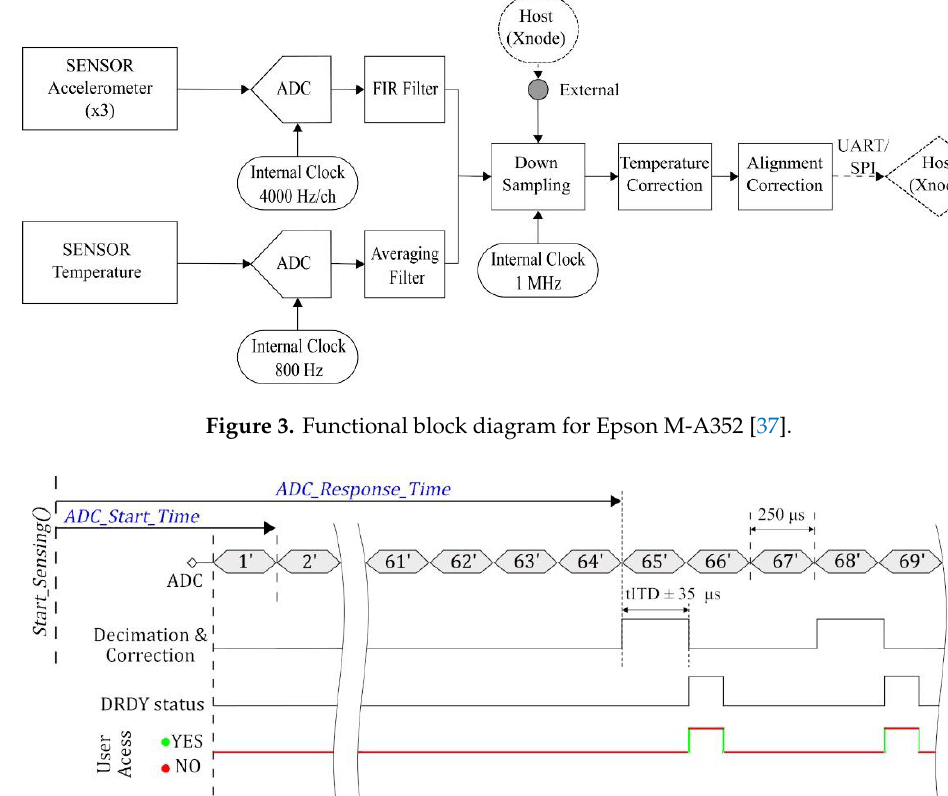
Figure 5. Histogram plot of mean-normalized delay in Data Ready (DRDY) for 100 runs. 3.2. Adaptive Algorithm for ADC Startup Delay Estimation in WSSs We propose an iterative algorithm, illustrated in Figure 6, to estimate the ADC_Start_Time delay in digital output sensors for accurate timestamping of samples. The approach can be implemented on WSSs without the need for any dedicated evaluation setup and direct access to the internal ADC. In the algorithm, at the start, we initialize the ADC_Response_Time with a minimum value corresponding to the transient response delay of the FIR. This wait delay is implemented with a 12 MHz XO tick precision on the Xnode, then the EXT pulse is sent out to the sensor, and we poll for the